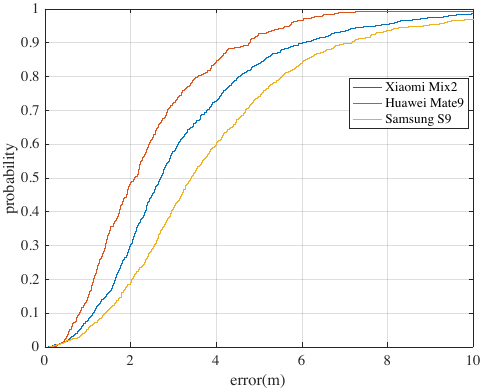
Figure 14. The CDFs of Wi-Fi-based positioning errors adopting the constructed RM with 3 different types of phones. (also using the classical kNN baseline